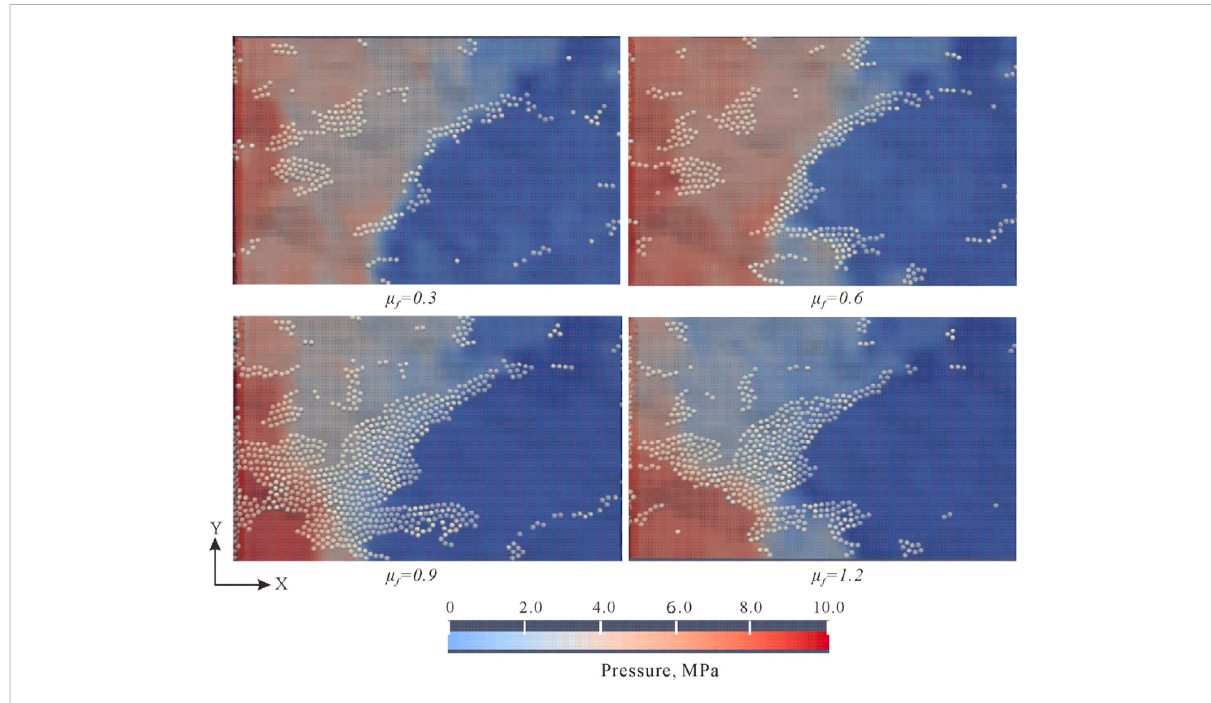
FIGURE 14 Plugging results of particles with different friction coef fi cients in JRC15.